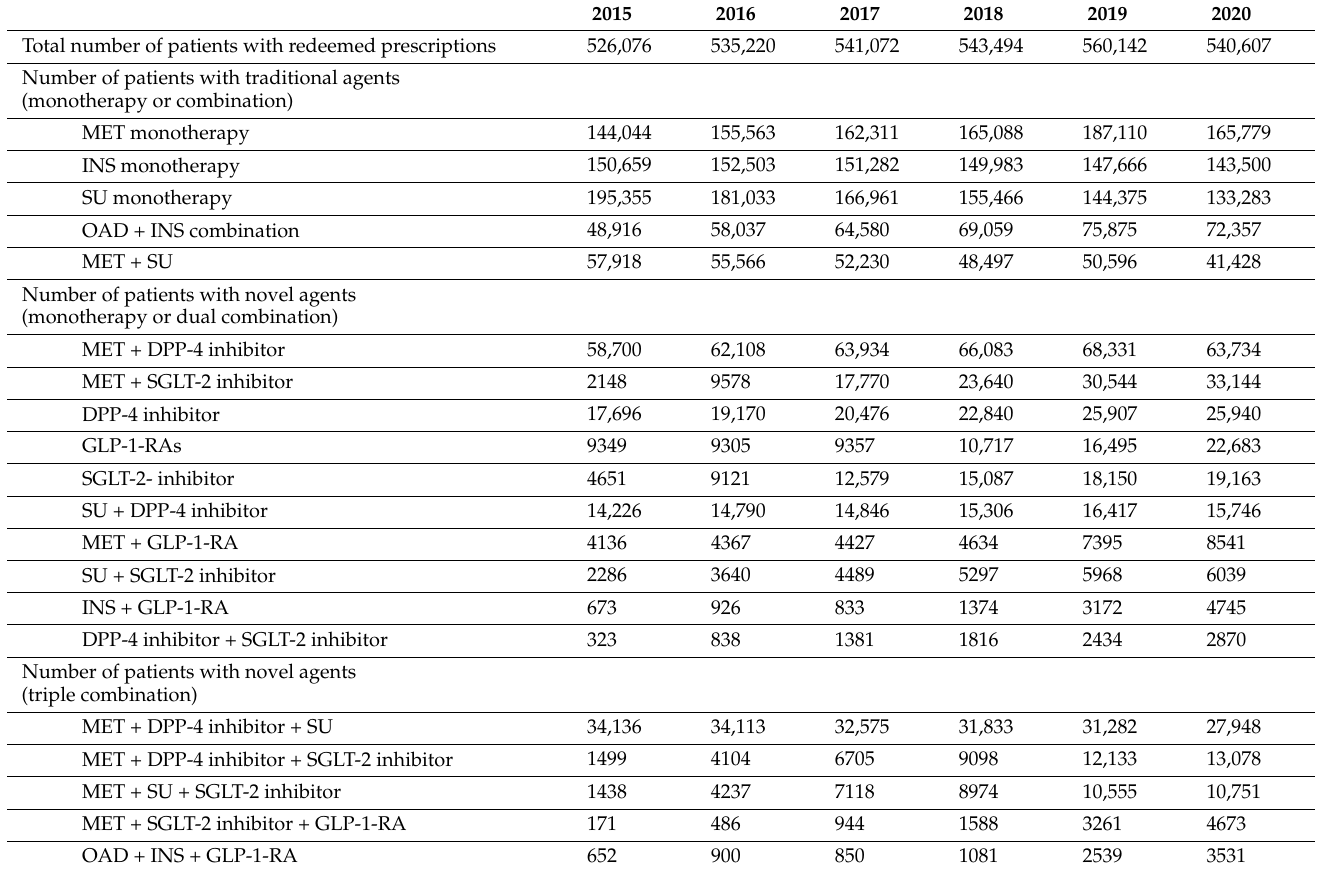
Table 2. Number of prevalent T2DM patients ( n ) treated with traditional or novel antihyperglycaemic agents in monotherapy or in combinations between 2015 and